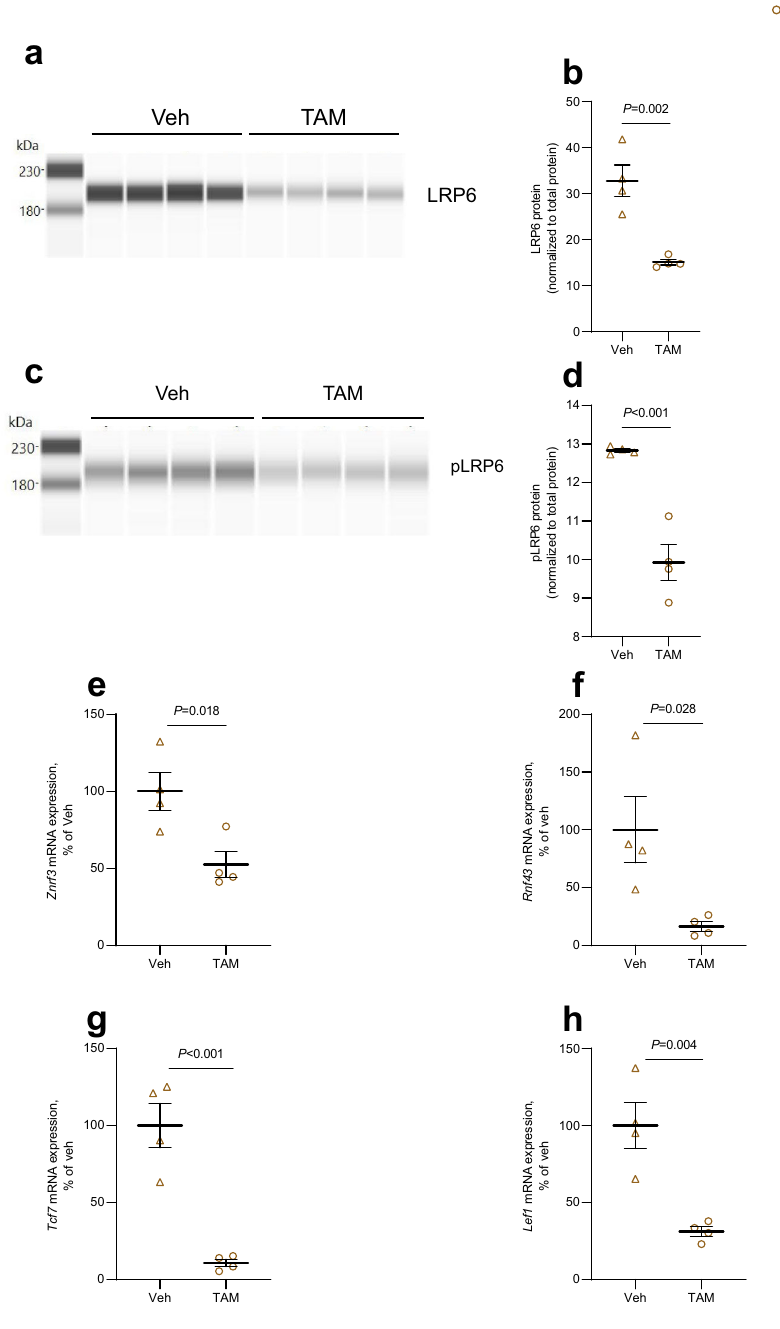
Fig. 6 Deletion of RSPO3 in osteoblasts decreased LRP6 and E3 ligases important for WNT canonical signaling. a , b LRP6 protein analysis in primary calvarial osteoblasts isolated from CAGGCre-ER-Rspo3 fl ox/ fl ox mice cultured in osteogenic media for 1 day with or without prior Rspo3 inactivation using tamoxifen (TAM). Lane view from the software in the capillary-based electrophoresis immunodetection system ( a ) and protein levels ( b ) normalized to total protein. c , d pLRP6 protein analysis in primary calvarial osteoblasts isolated from CAGGCre-ER-Rspo3 fl ox/ fl ox mice cultured in osteogenic media for 1 day with or without prior Rspo3 inactivation using tamoxifen (TAM). Lane view from the software in the capillary-based electrophoresis immunodetection system ( c ) and protein levels ( d ) normalized to total protein. e – h mRNA expression analyses of Znrf3 ( e ), Rnf43 ( f ), Tcf7 ( g ) and Lef1 ( h ) in primary calvarial osteoblasts isolated from CAGGCre-ER-Rspo3 fl ox/ fl ox mice cultured in osteogenic media for 6 days with or without prior Rspo3 inactivation using TAM. Veh = vehicle. Individual values are presented in all graphs with the mean presented as horizontal lines and ±SEM as vertical lines. n = 4 wells per group. Experiments were repeated one ( e , f ), two ( a , b , g , h ) or at least three ( c , d ) times. Statistical analyses were performed using two-sided Student ’ s t test. Source data are provided as a Source Data fi